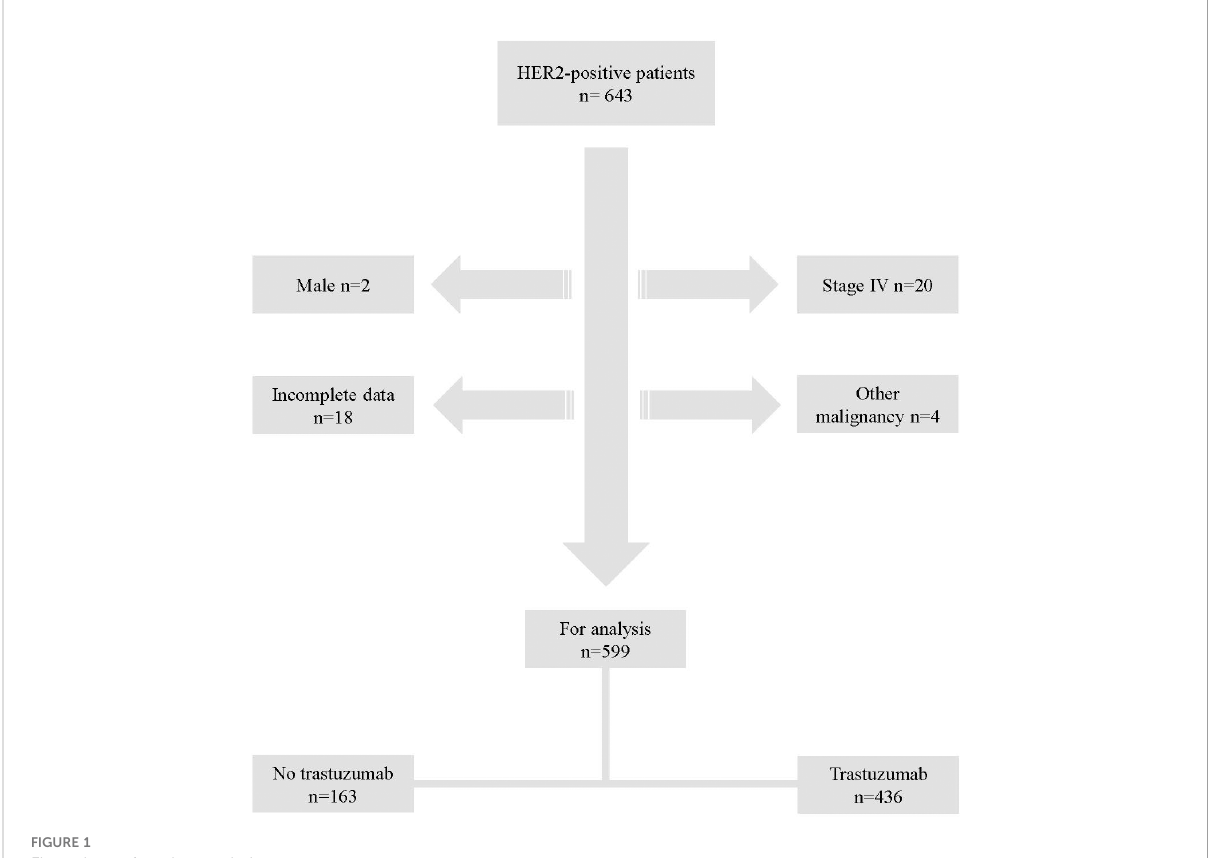
FIGURE 1 Flow chart of study